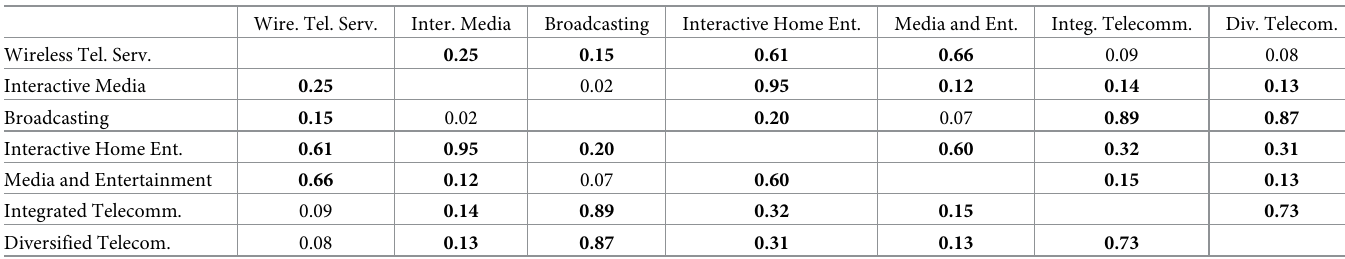
Table 7. Communication services